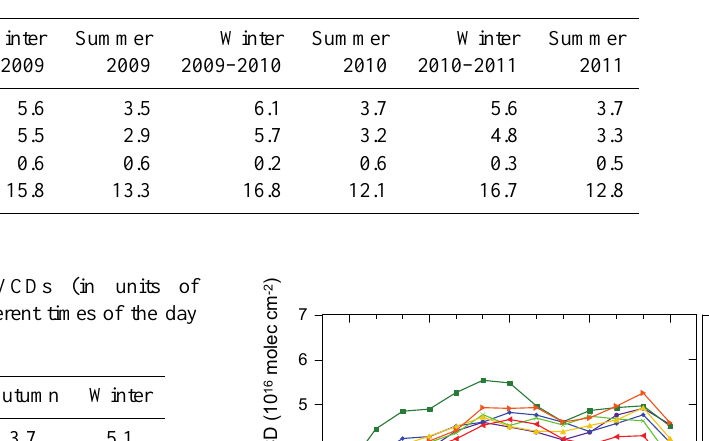
Table 2. Tropospheric NO 2 VCDs (in units of 10 16 moleculescm − 2 ) over Beijing in winter and summer months from 2008 to 2011.